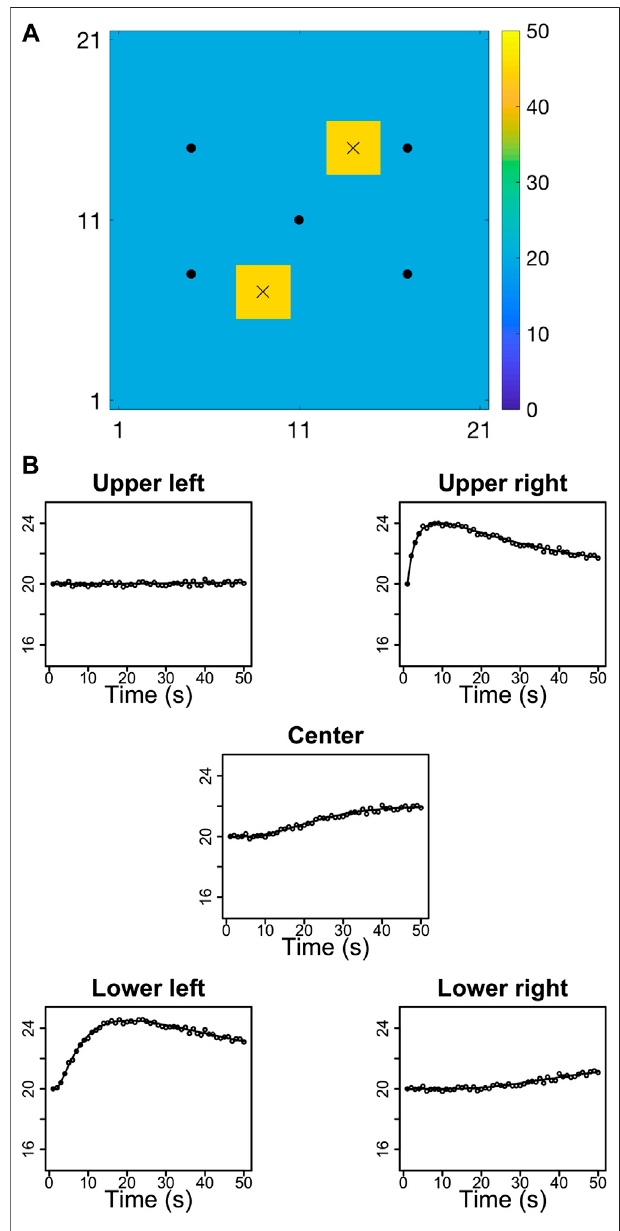
FIGURE 13 | Set up from the two yellow area test